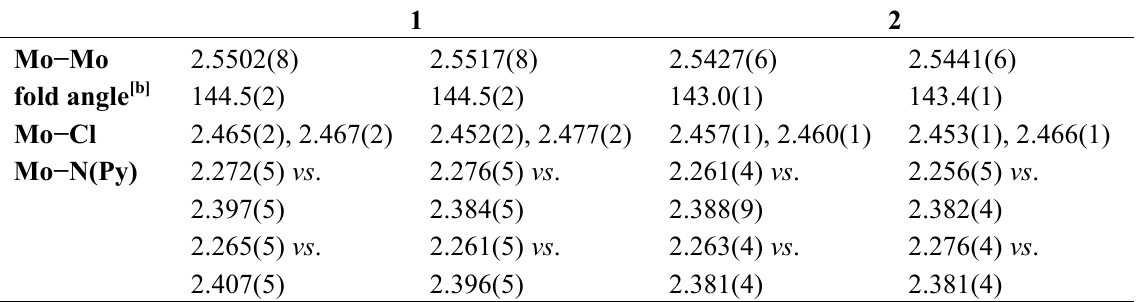
Figure 1. An ORTEP drawing of [Mo